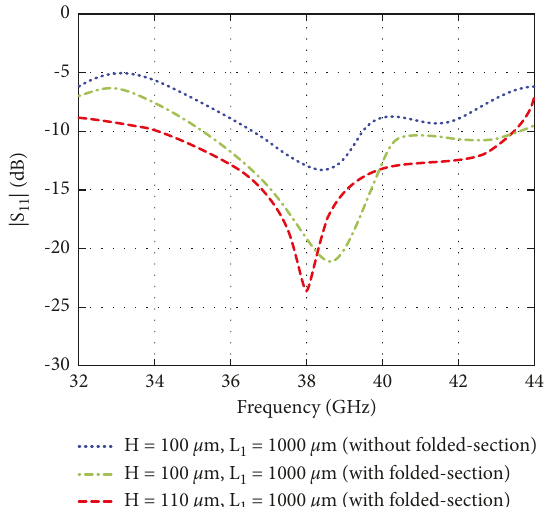
Figure 3: Reflection coefficient traces show a selection of the optimized dimensions of the proposed